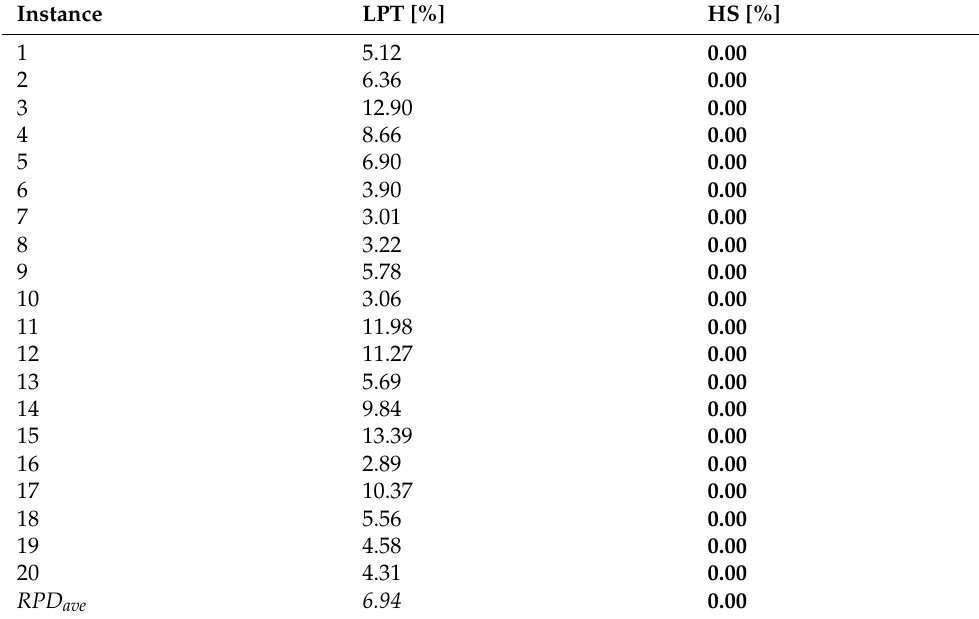
Table 8. Comparison between LPT rule and HS